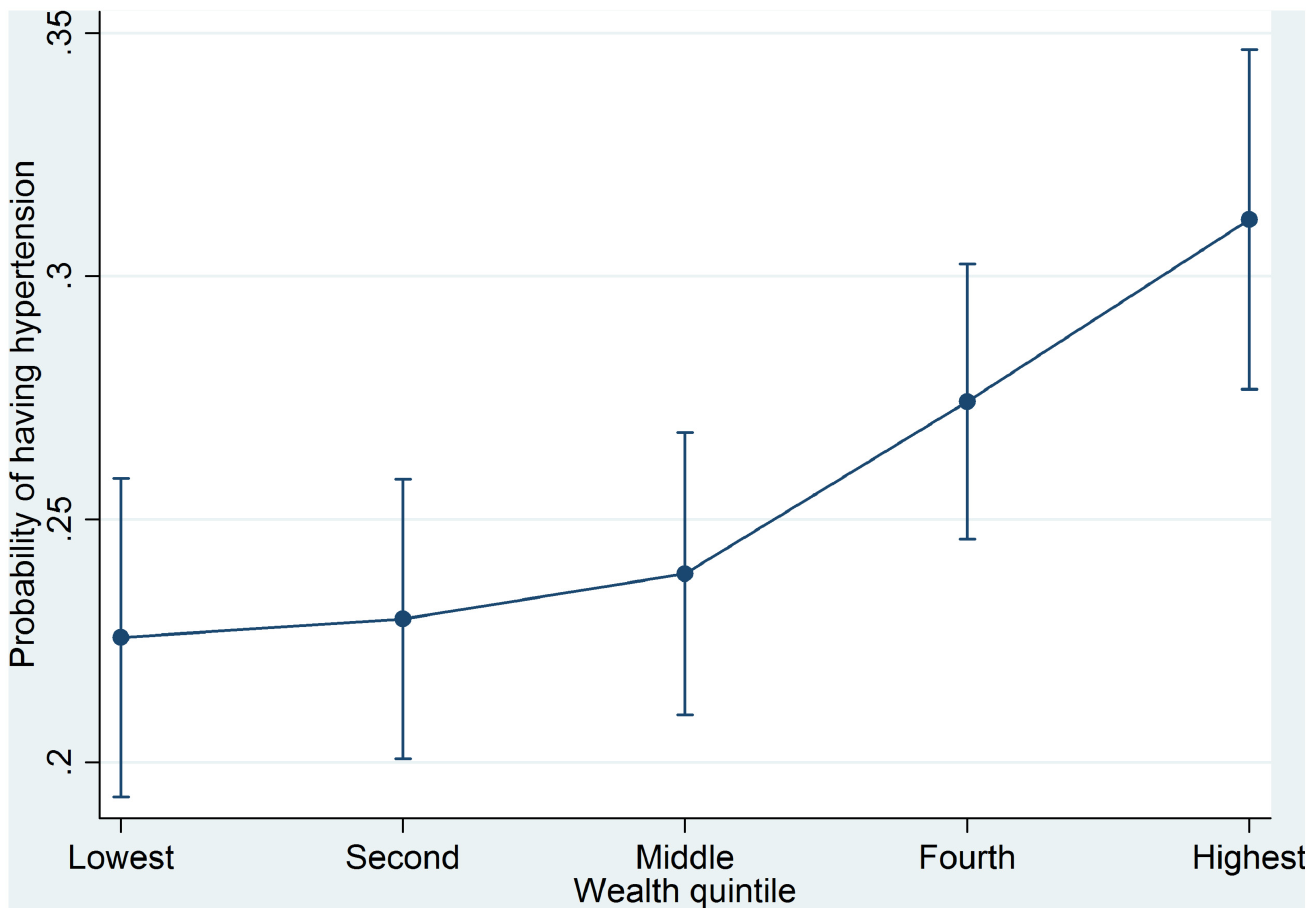
Fig 1. Predicted probabilities of having hypertension by wealth